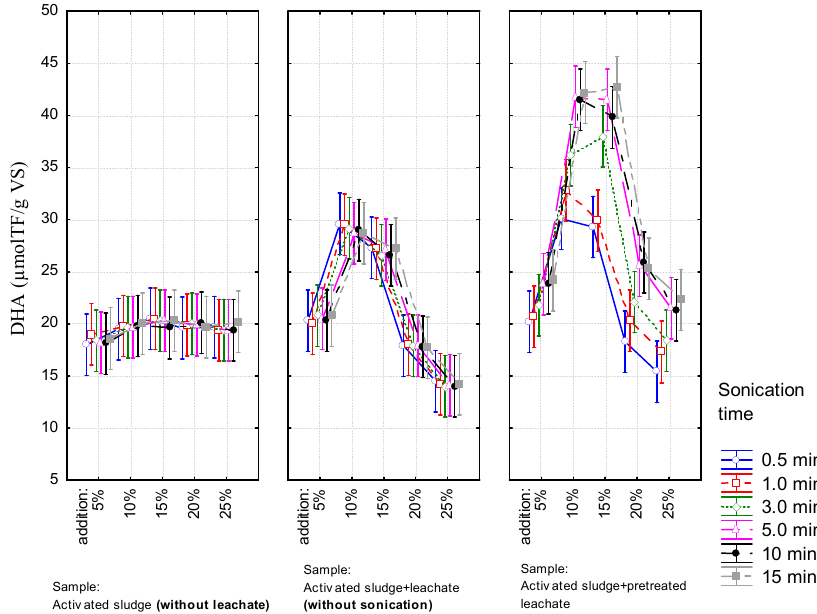
Figure 3. The DHA activity profile at different the volumetric ratio of leachate in